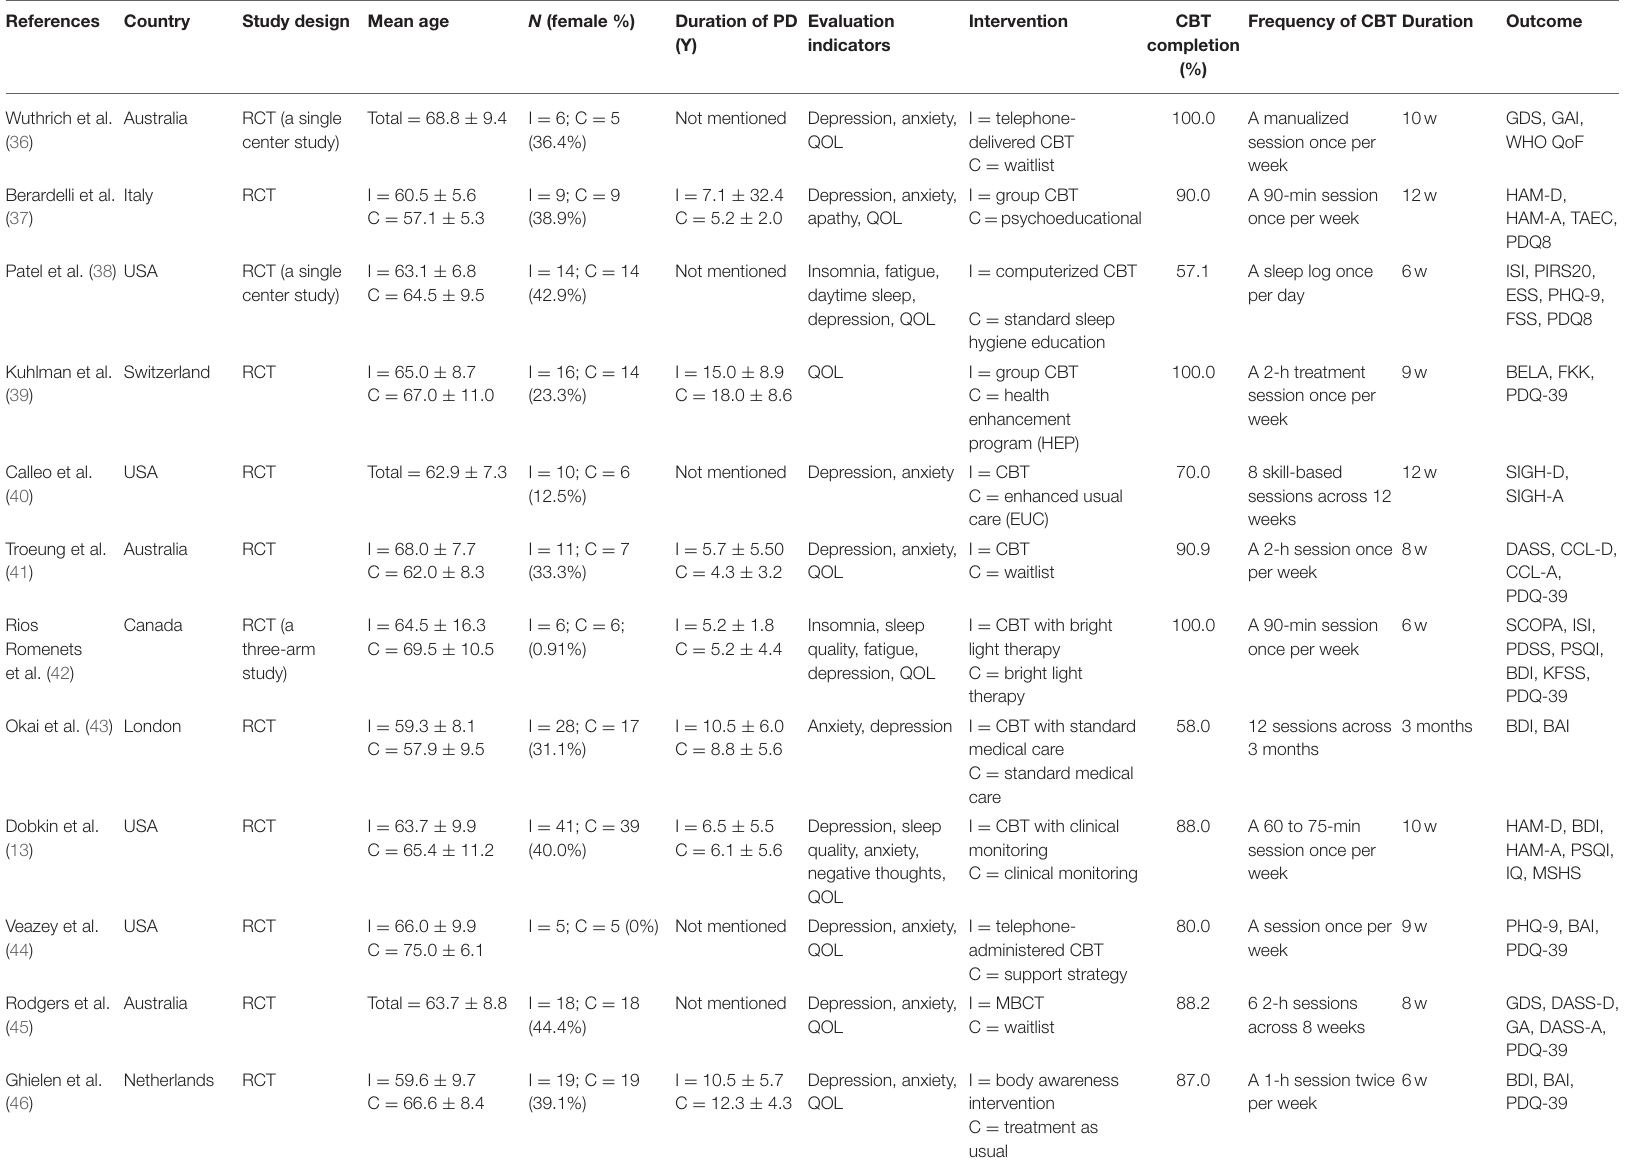
TABLE 1 | Main characteristics of